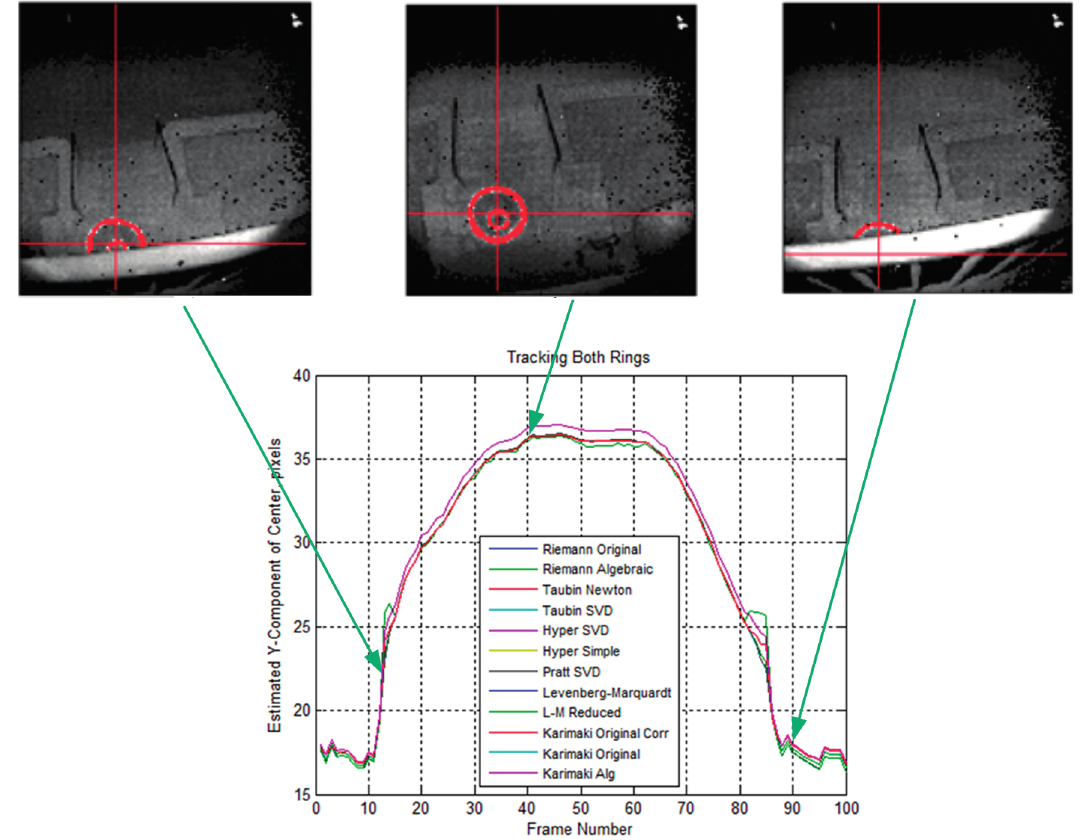
Figure 8. Comparison study of different circle fitting algorithms by using both inner and outer